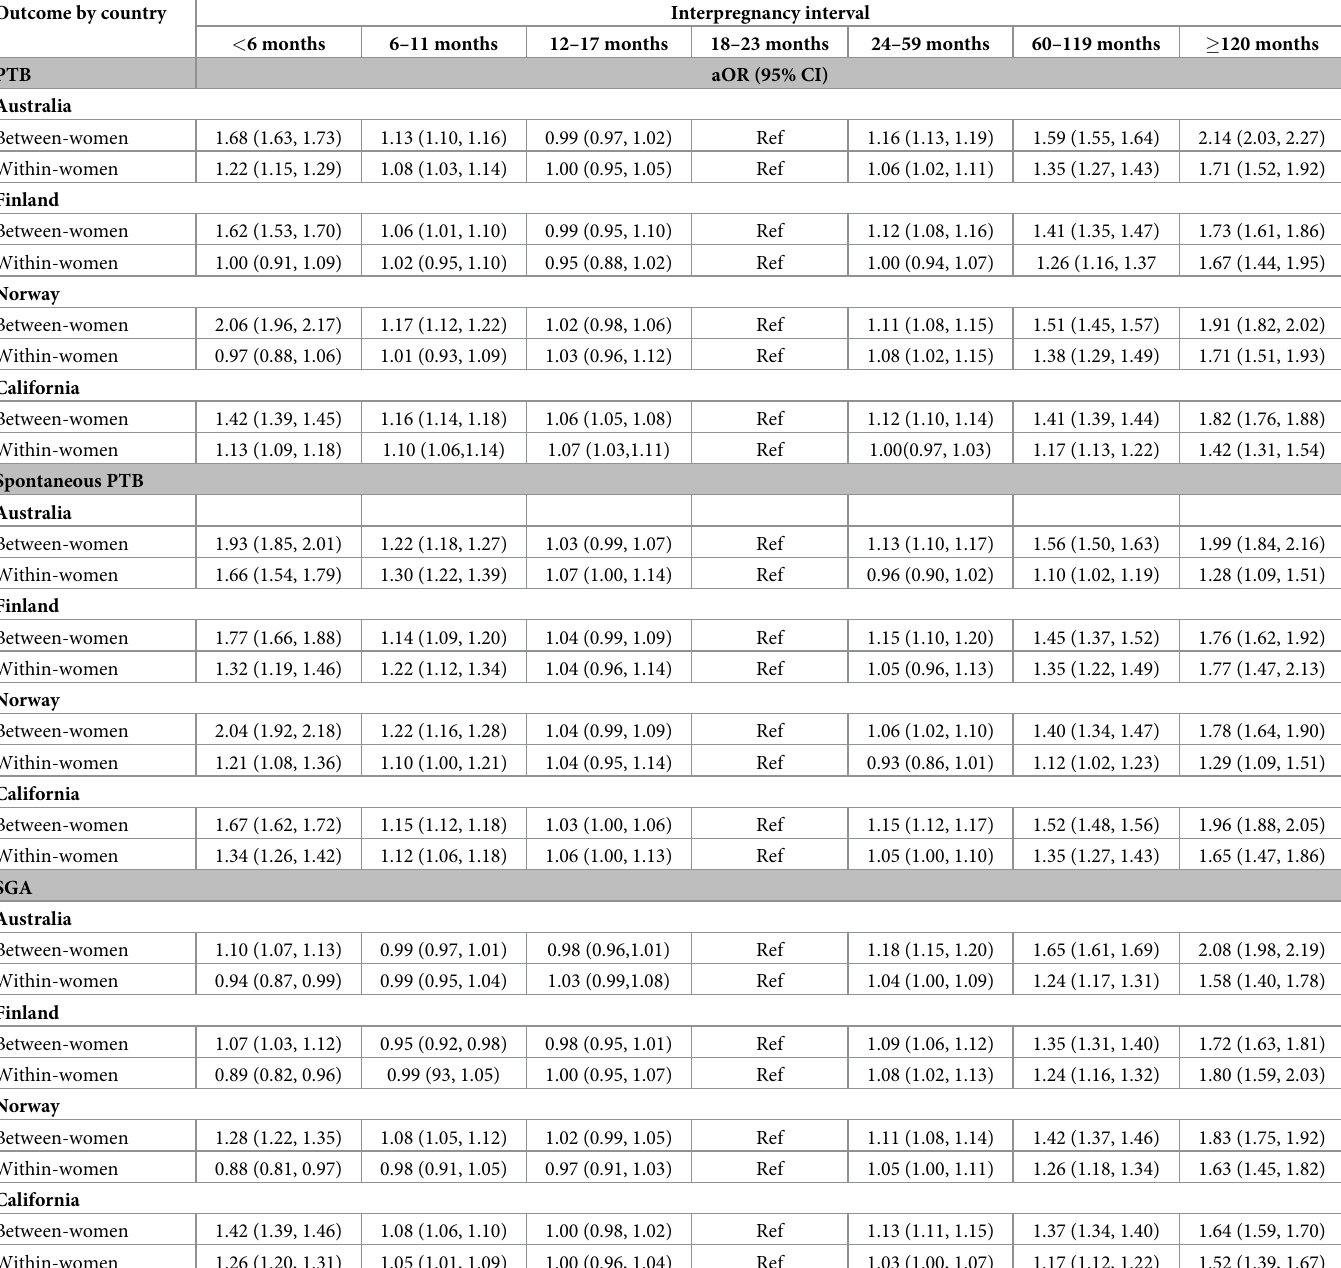
Table 3. Adjusted odds ratios (aOR) and 95% confidence intervals (CI) between interpregnancy interval and adverse birth outcomes among births in between- women � and within-women �� analyses across the four countries. Outcome by